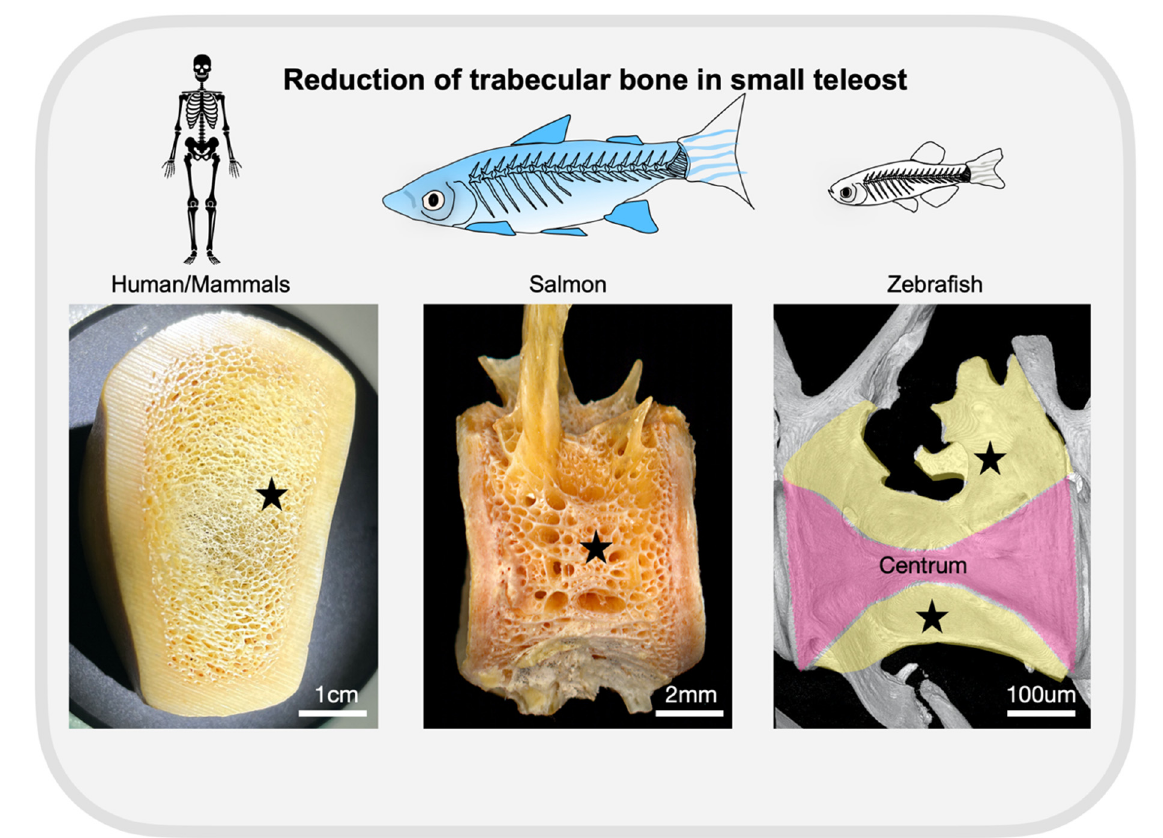
Figure 4. Trabecular bones in fish are located surrounding the centrum while in mammals they are surrounded by cortical bones. Small teleost species show only a few trabeculations (stars) when compared to larger fish. As an example of trabecular bone in mammals, we are showing a section of tibia from a dog, provided by the Histology Facility at the University of Bristol. The picture of salmon was adapted from [137] with permission from the correspondent authors. Note the reduction of trabeculations in zebrafish (synchrotron image, trabeculation shown in yellow and the centrum in pink). Scale bars are as annotated.